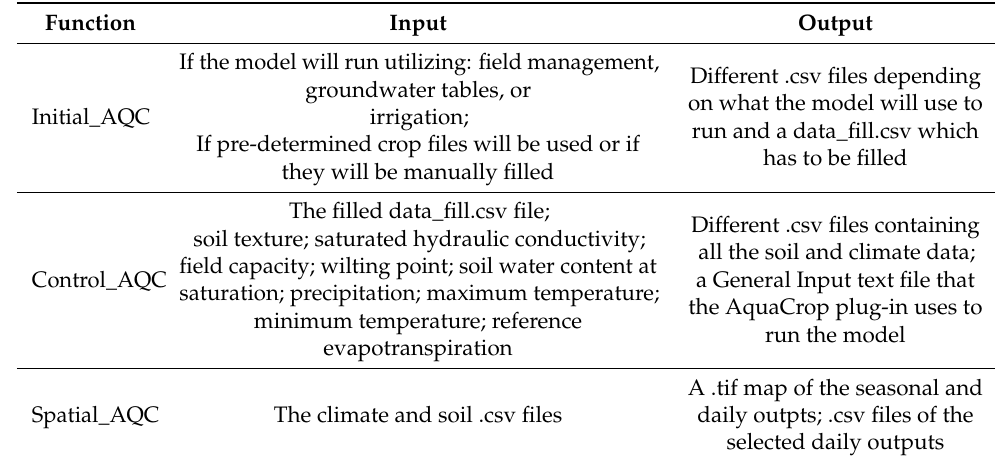
Figure 3. Workflow of the SpatialAquaCrop application. Table 1. Input and output of major R functions within the SpatialAquaCrop